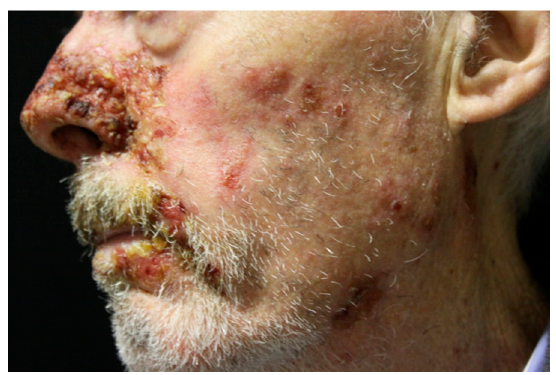
Figure 4. PNP head and neck lesions. Erythema and ulceration with oozing and crusting.